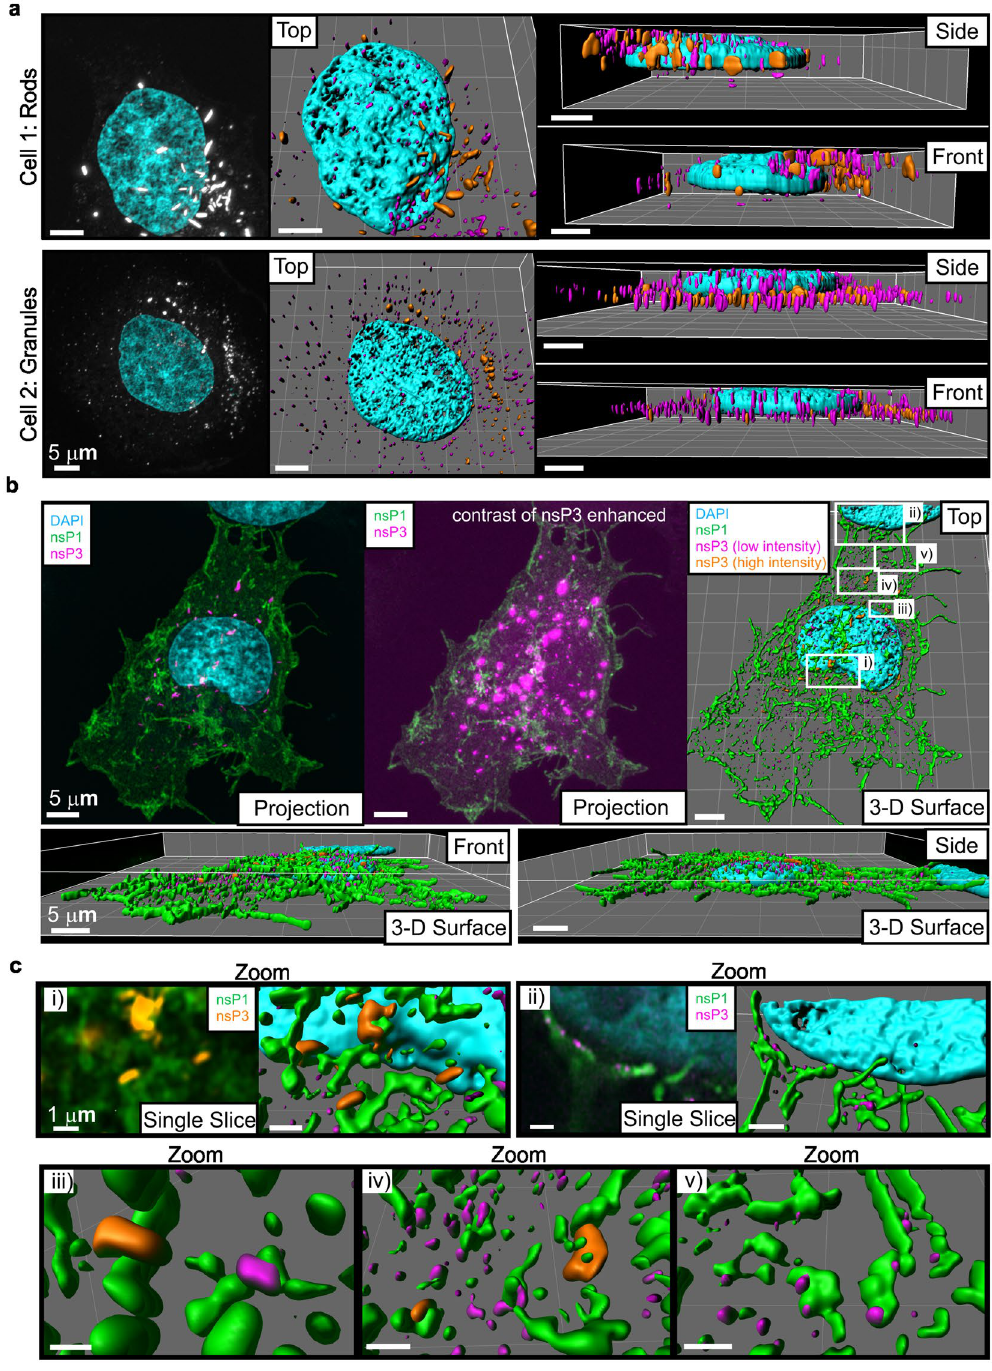
Figure 6. 3-D visualisation of clusters of SNAP-nsP3 and proximity with nsP1-rich regions. HuH-7 cells were transfected with CHIKV SNAP-P3 sg-ZsGreen , fixed after 12 hours, labelled with BG-TMR- Star and imaged with a Zeiss LSM 880 confocal system with Airyscan, operated in the super-resolution mode. ( a ) Z-stacks consisted of 43 sections over an axial distance of 6.7 µ m (Cell 1) or 27 sections over 5.2 µ m (Cell 2). A lens power of 63 × (1.4 numerical aperture) was used with a digital zoom factor of 4 (Cell 1) or 3 (Cell 2). Voxel sizes were 37 × 37 × 150 nm (Cell 1) or 37 × 37 × 200 nm (Cell 2). Images on the left represent a maximum-intensity projection of the BG-TMR- Star channel. Images on the right show surface views of the 3-D reconstruction from a cell (Cell 1) containing both rod-like structures and granular clusters. Two separate thresholds were applied during rendering of surfaces to visualise clusters with high-fluorescence-intensity (orange) and low- fluorescence-intensity (pink). Top, front and side views of the 3-D volumes are shown. Compared to cell 1, cell 2 contained more low-intensity, granular clusters. DAPI-stained cell nuclei are displayed in cyan. ( b ) Antibodies detecting nsP1 were used for immunostaining of HuH-7 cells that were prepared as in ( a ). Z-stack